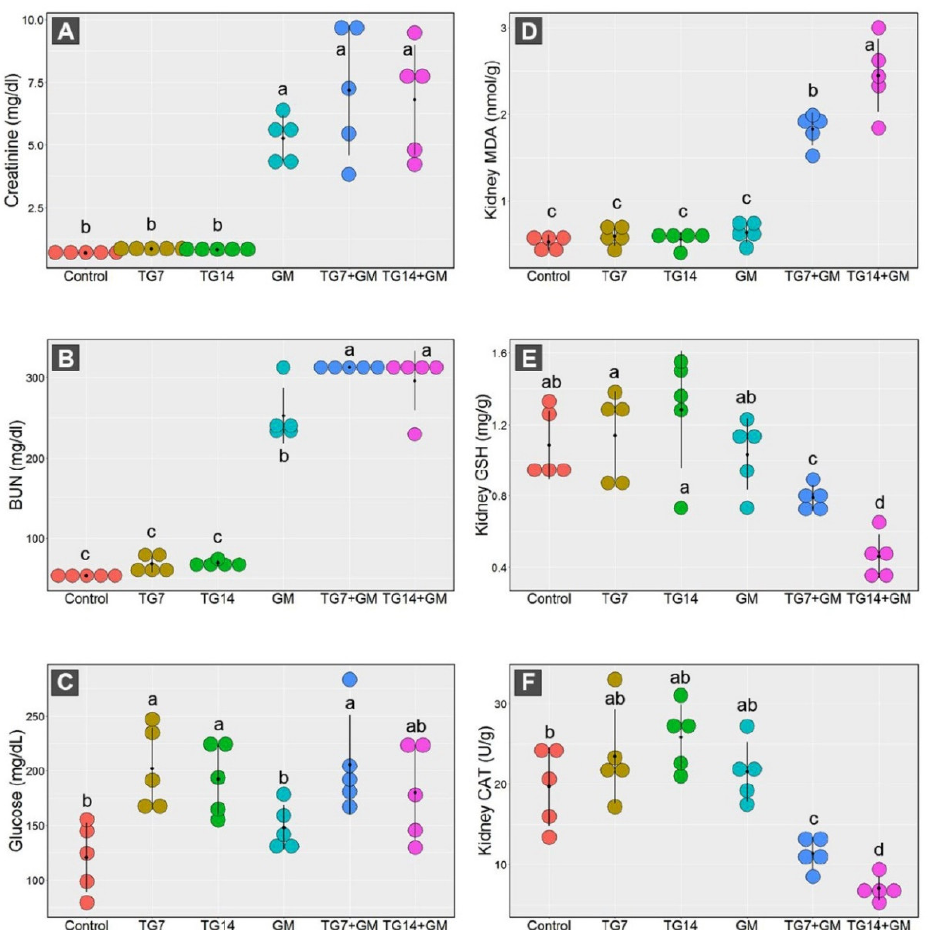
Figure 2. Dot plot panel with the means (black dot) and 95% confidence interval (the stretching out black lines from the means) of the creatinine ( A ), BUN (blood urea nitrogen) ( B ), glucose ( C ), MDA (malondialdehyde) ( D ), GSH (reduced-glutathione) ( E ), CAT (catalase enzyme) ( F ) in the control, TG7 (tigecycline, 7 mg/kg), TG14 (tigecycline, 14 mg/kg), GM (gentamicin), TG7+GM, and TG14+GM groups. The different lower case letters are considered statistically significant at p ≤